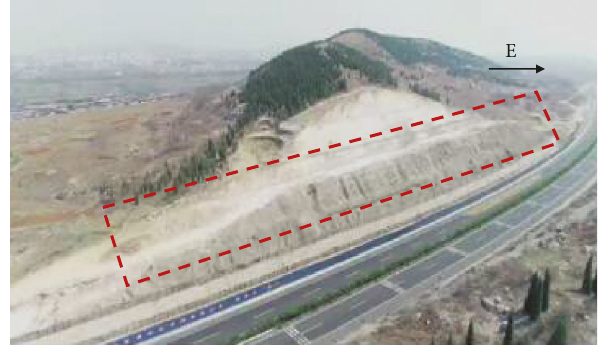
Figure 1: Schematic diagram of the explosion